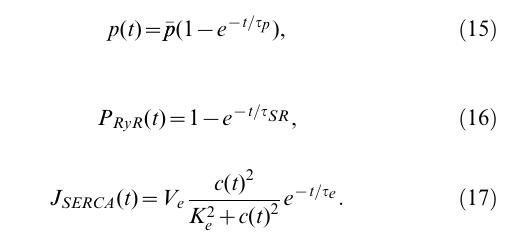
dynamics of an ASMC i